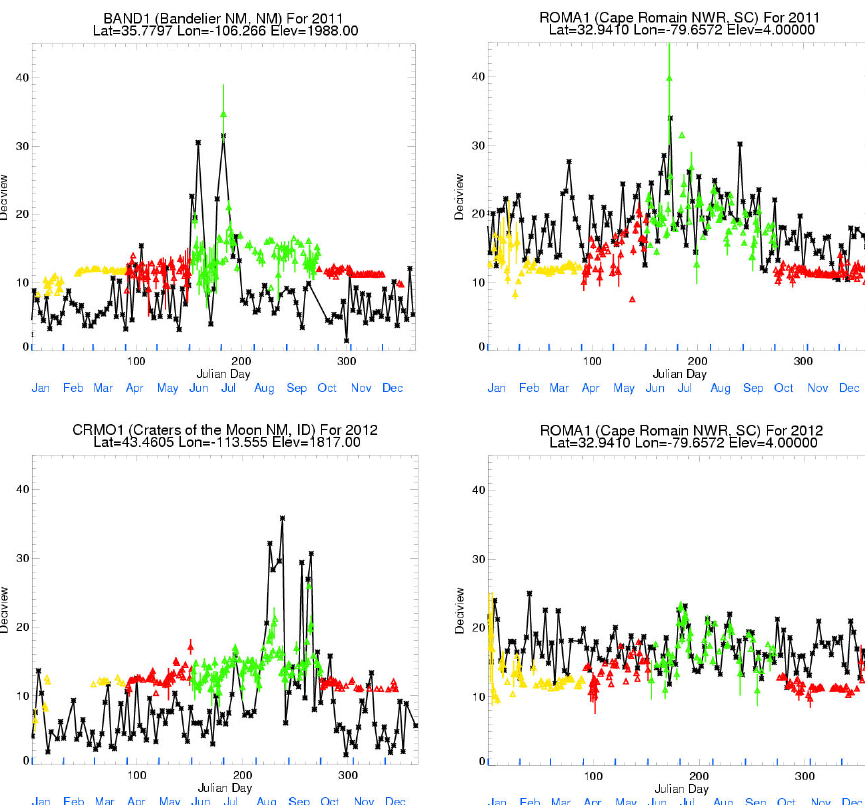
Figure 7. Top left panel: time series plot for 2011 of Bandelier National Monument in New Mexico of daily mean d V for IMPROVE (black line) and IMPROVE regression (bias-corrected) ABI retrieval (triangle symbol is daily mean d V with standard deviation line); top right panel: same as top panel but for time series plot for 2011 of Cape Romain National Wildlife Refuge in South Carolina; bottom left panel: same as top panel but for time series plot for 2012 of Craters of the Moon National Monument in Idaho; bottom right panel: same as top panel but for time series plot for 2012 of Cape Romain National Wildlife Refuge in South